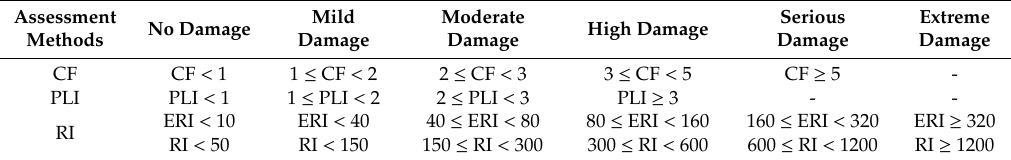
Table 1. Evaluation criteria for di ff erent evaluation methods.